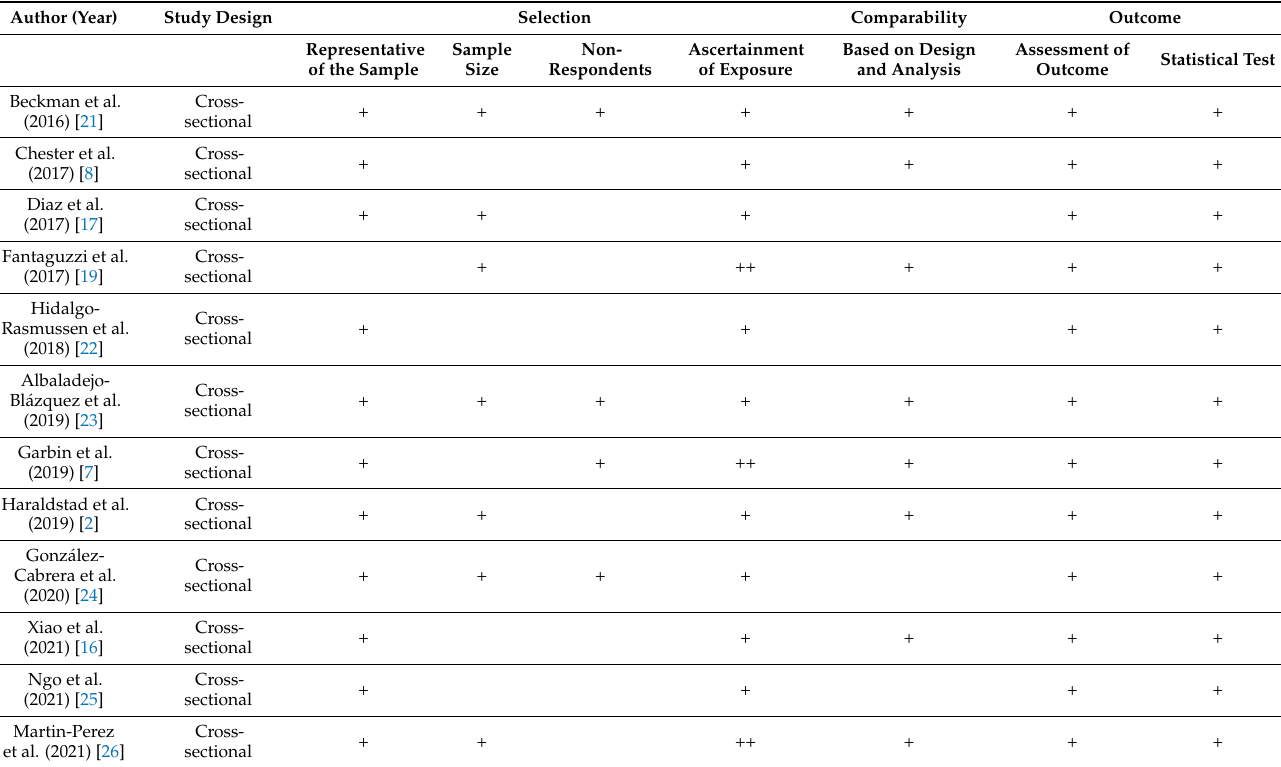
Table 1. Results of the critical appraisal of the included studies. (+ for self-reported outcomes; ++ for the outcome with independent blind